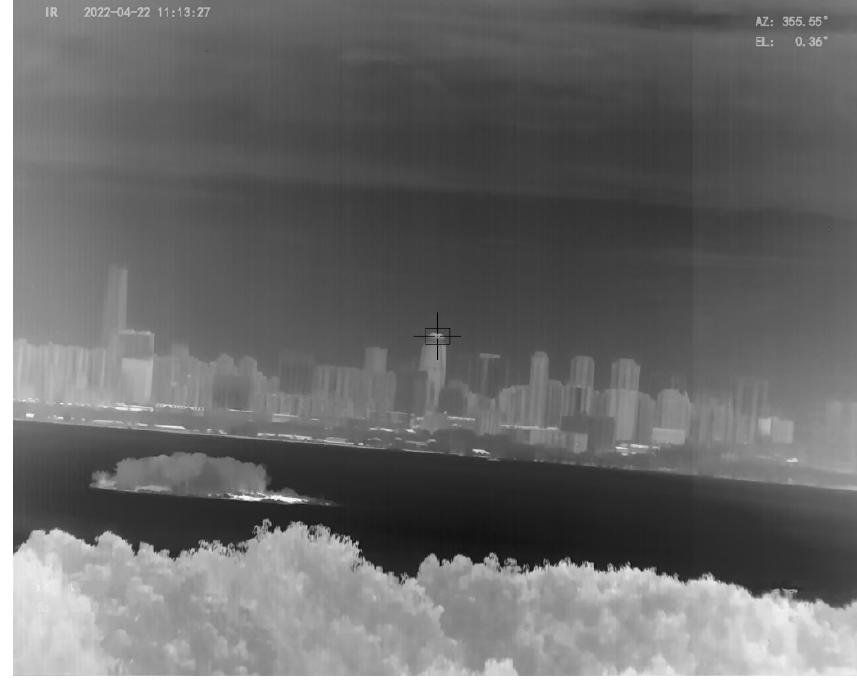
Figure 9. The image rotation phenomenon in the experiment.